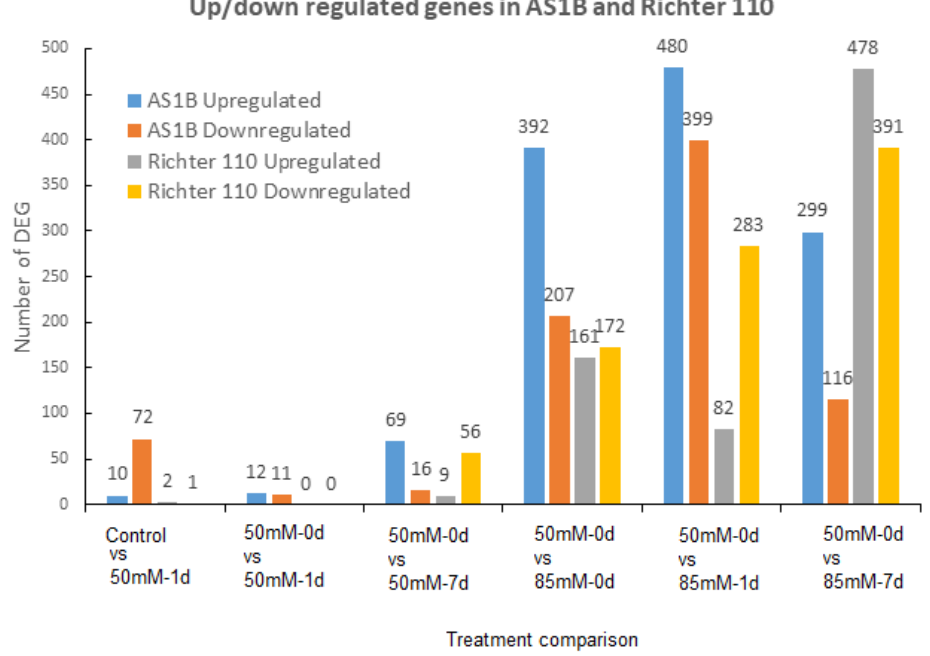
Figure 2. Number of DEGs detected in AS1B and Richter 110 through all the conditions.